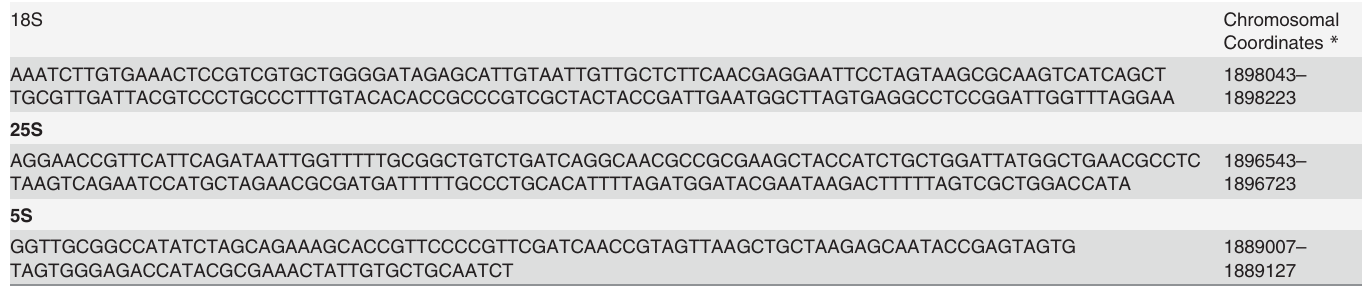
Table 1. Probe Sequences for Non-Isotopic